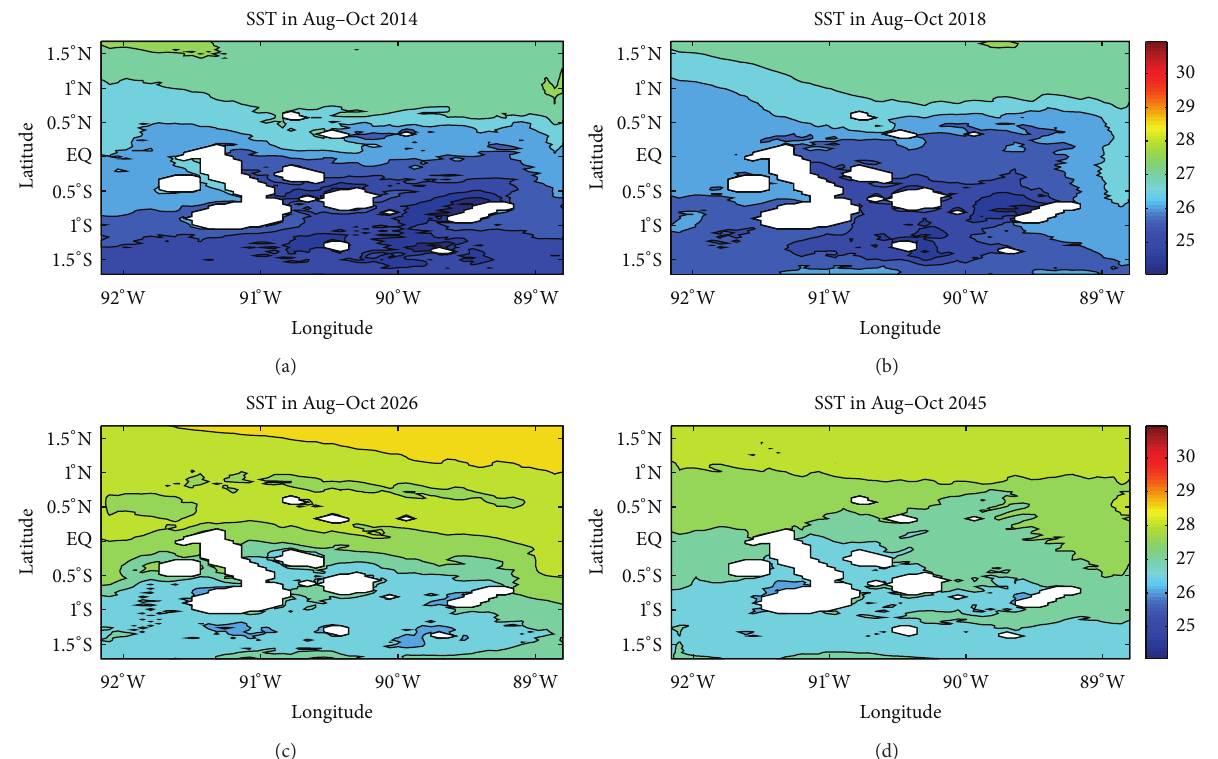
Figure 10: The SST around the GMR during the La Ni˜na cases: (a) in Aug–Oct in 2014, (b) in Aug–Oct in 2018, (c) in Aug–Oct in 2026, and (d) in Aug–Oct in